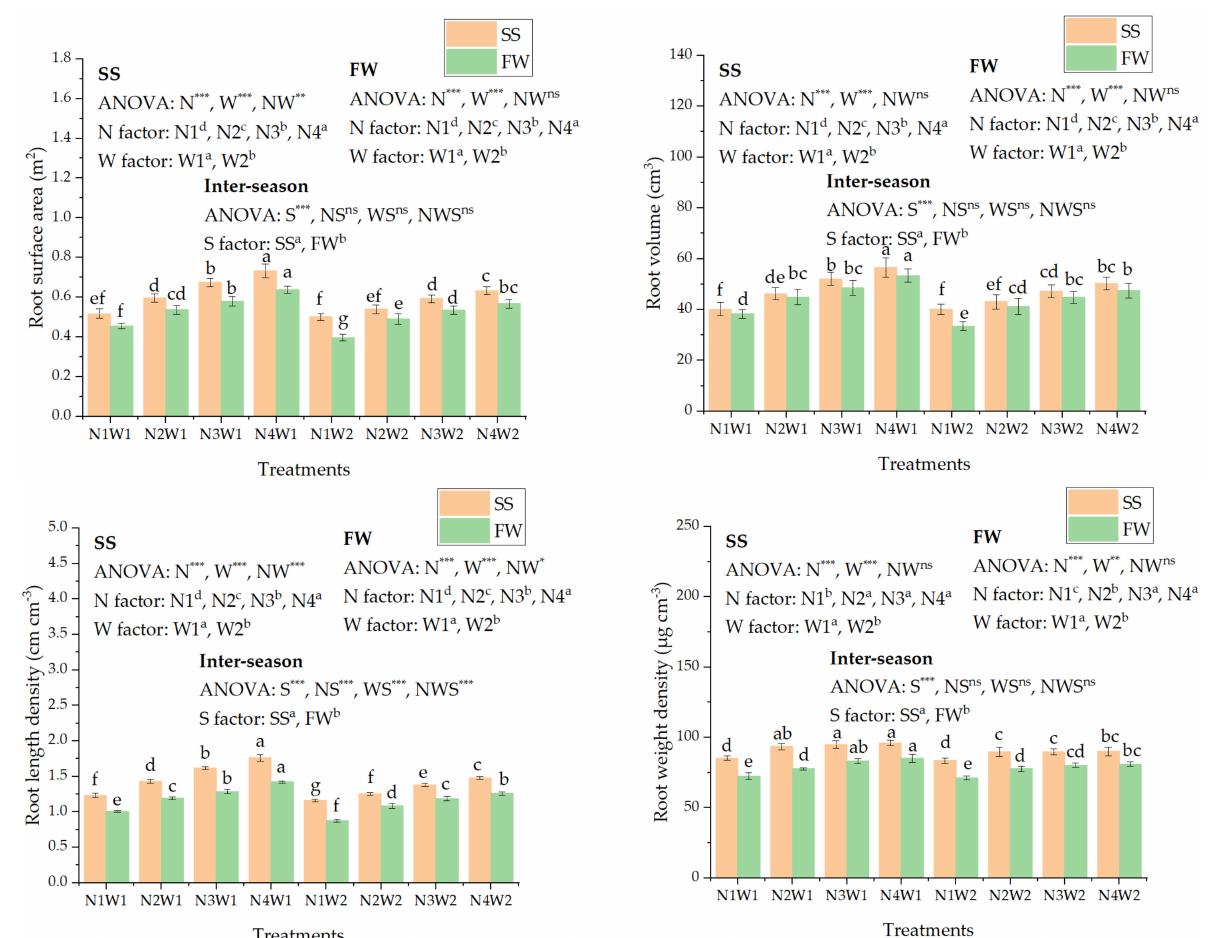
Figure 3. Effects of emitter density, irrigation level, and season on root morphology for both spring–summer (SS) and fall-winter (FW). N1, N2, N3, N4, W1, W2, SS, and FW: one emitter per plant, two emitters per plant, three emitters per plant, four emitters per plant, full irrigation, deficit irrigation, spring–summer cropping season, and fall-winter cropping season, respectively. *, ** and ***, ns; significant at p < 0.05, significant at p < 0.01, significant at p < 0.001, and non-significant at p > 0.05. Values that are followed by different letters within the same columns differ significantly at p < 0.05. Data are given in means ± standard deviations ( n = 4) shown by vertical